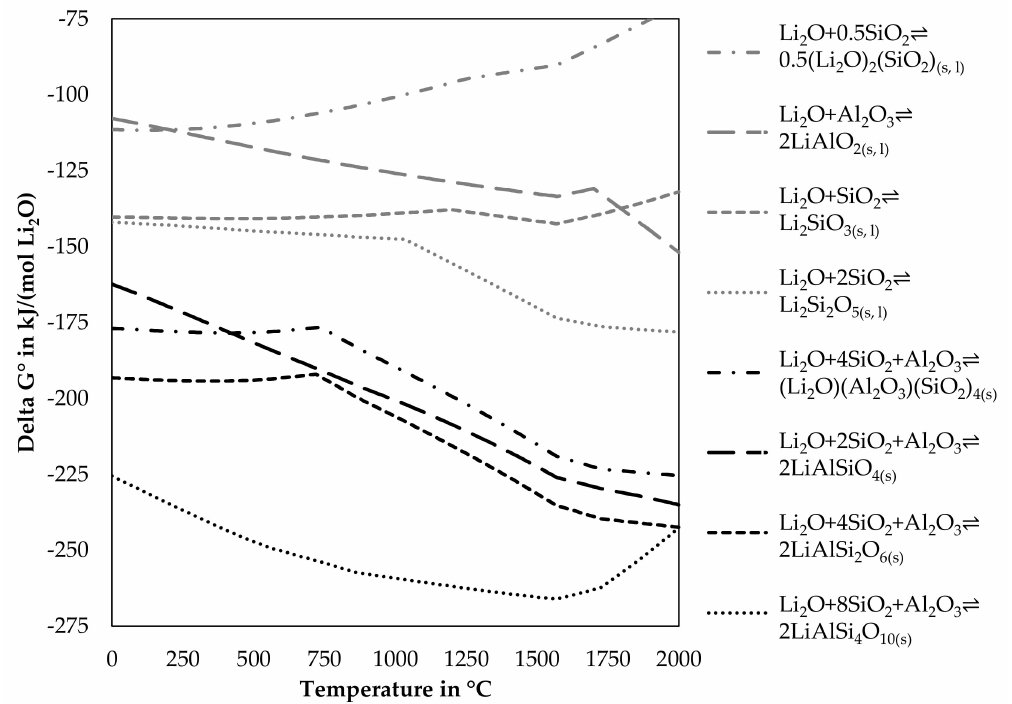
Figure 5. Simulated change of Gibbs energy for the reaction of lithium oxide with alumina, silica and alumina and